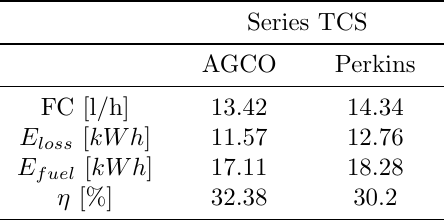
Table 6: The simulation results of the